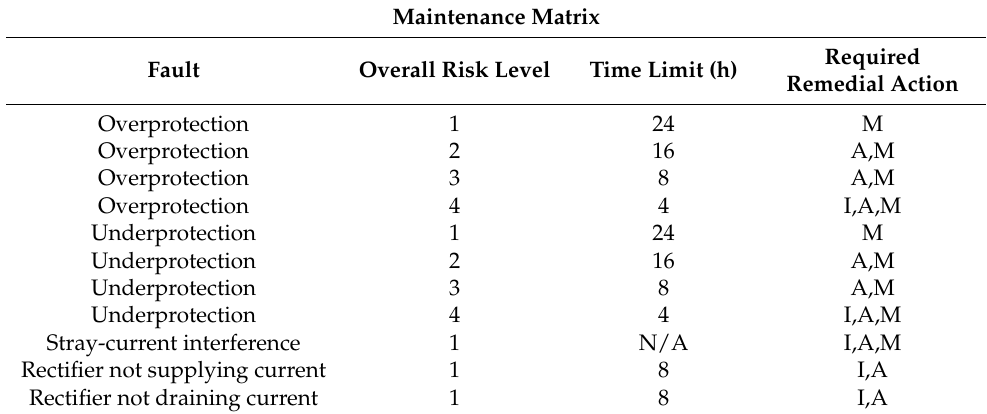
Table 3. Maintenance matrix.